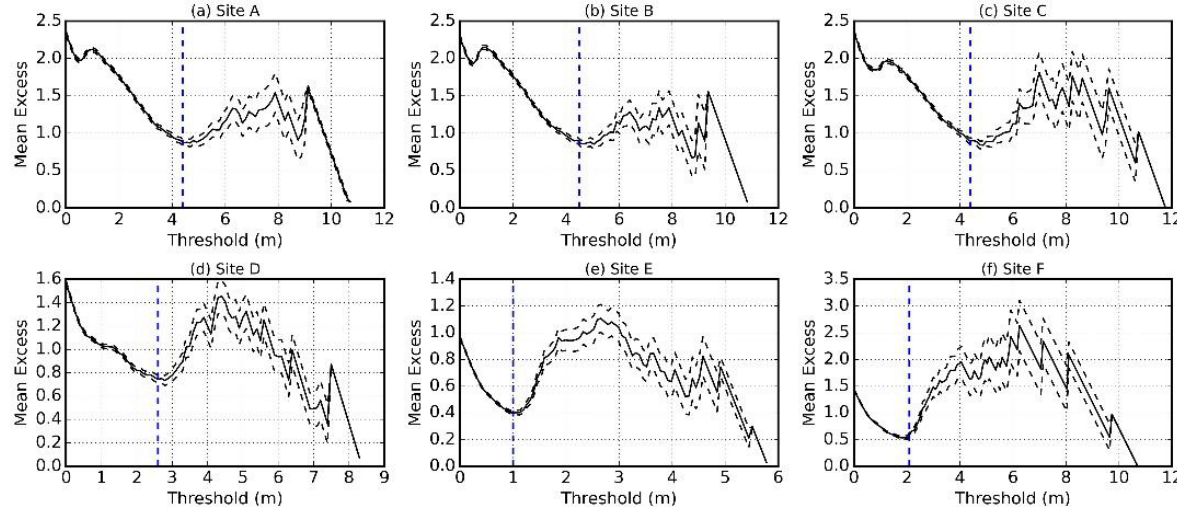
Figure 26. Mean residual life plot for the threshold selection at six sites.